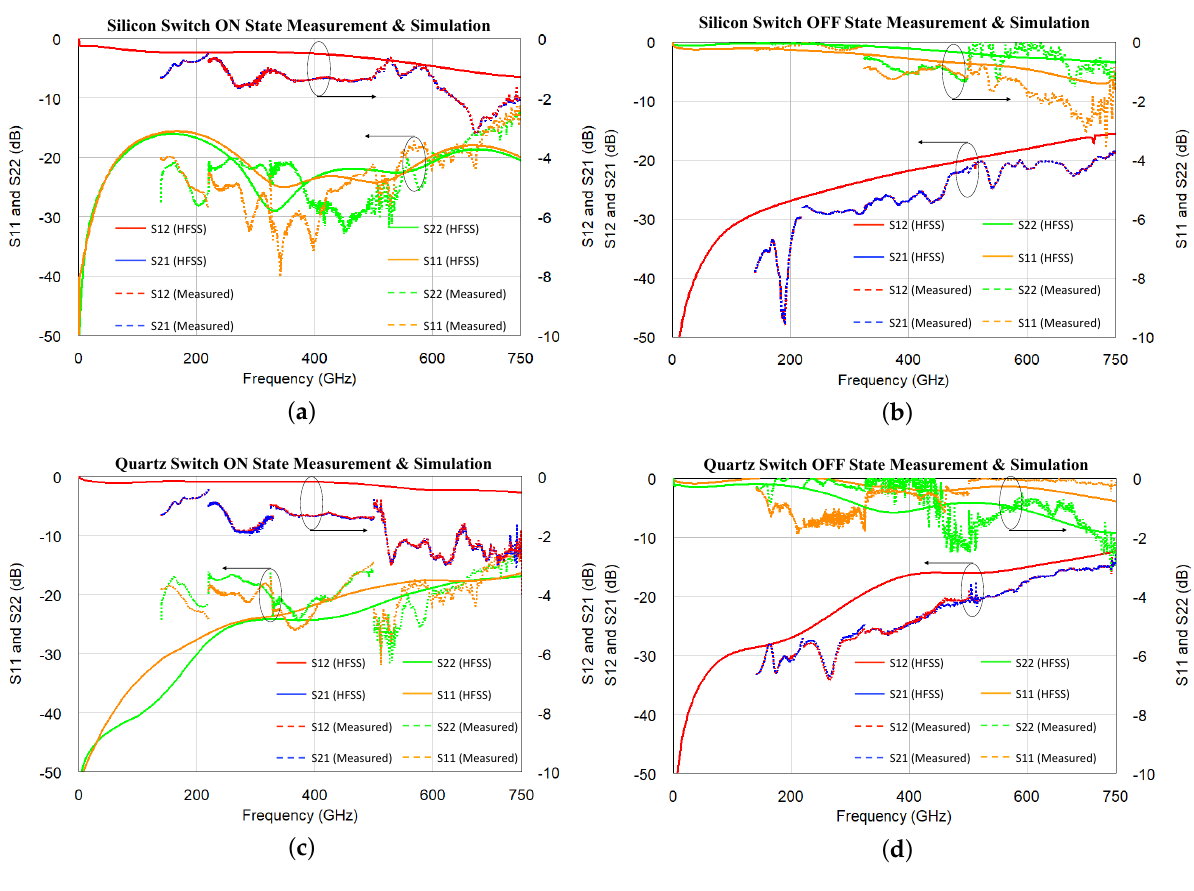
Figure 18. The THz MEMS switch HFSS simulation measurement comparison. ( a ) Silicon switch ON state measurement and simulation. ( b ) Silicon switch OFF state measurement and simulation. ( c ) Quartz switch ON state measurement and simulation. ( d ) Quartz switch OFF state measurement and